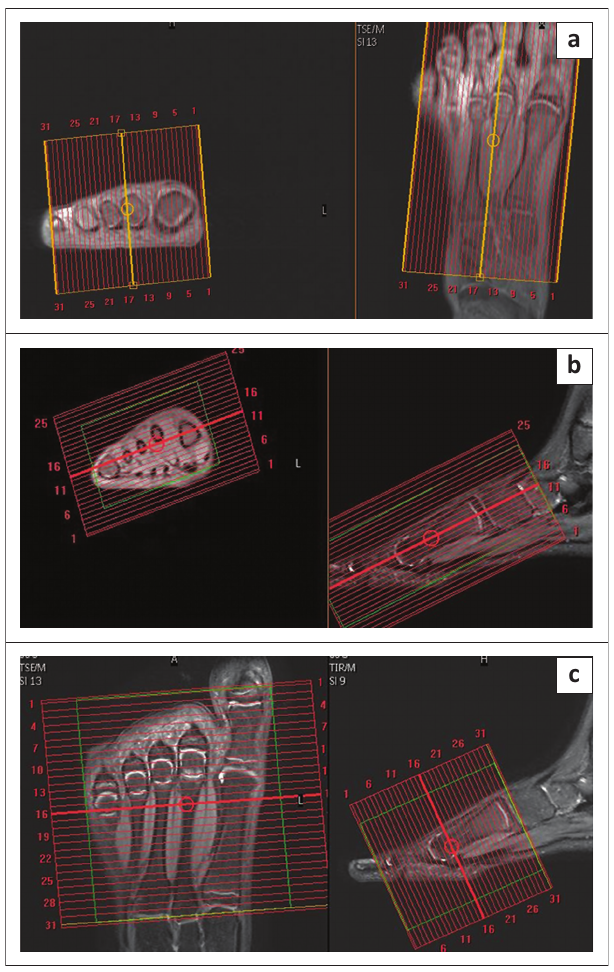
FIGURE 2: Scout views used to plan imaging planes. (a) sagittal plane, (b) long axis plane and (c) short axis